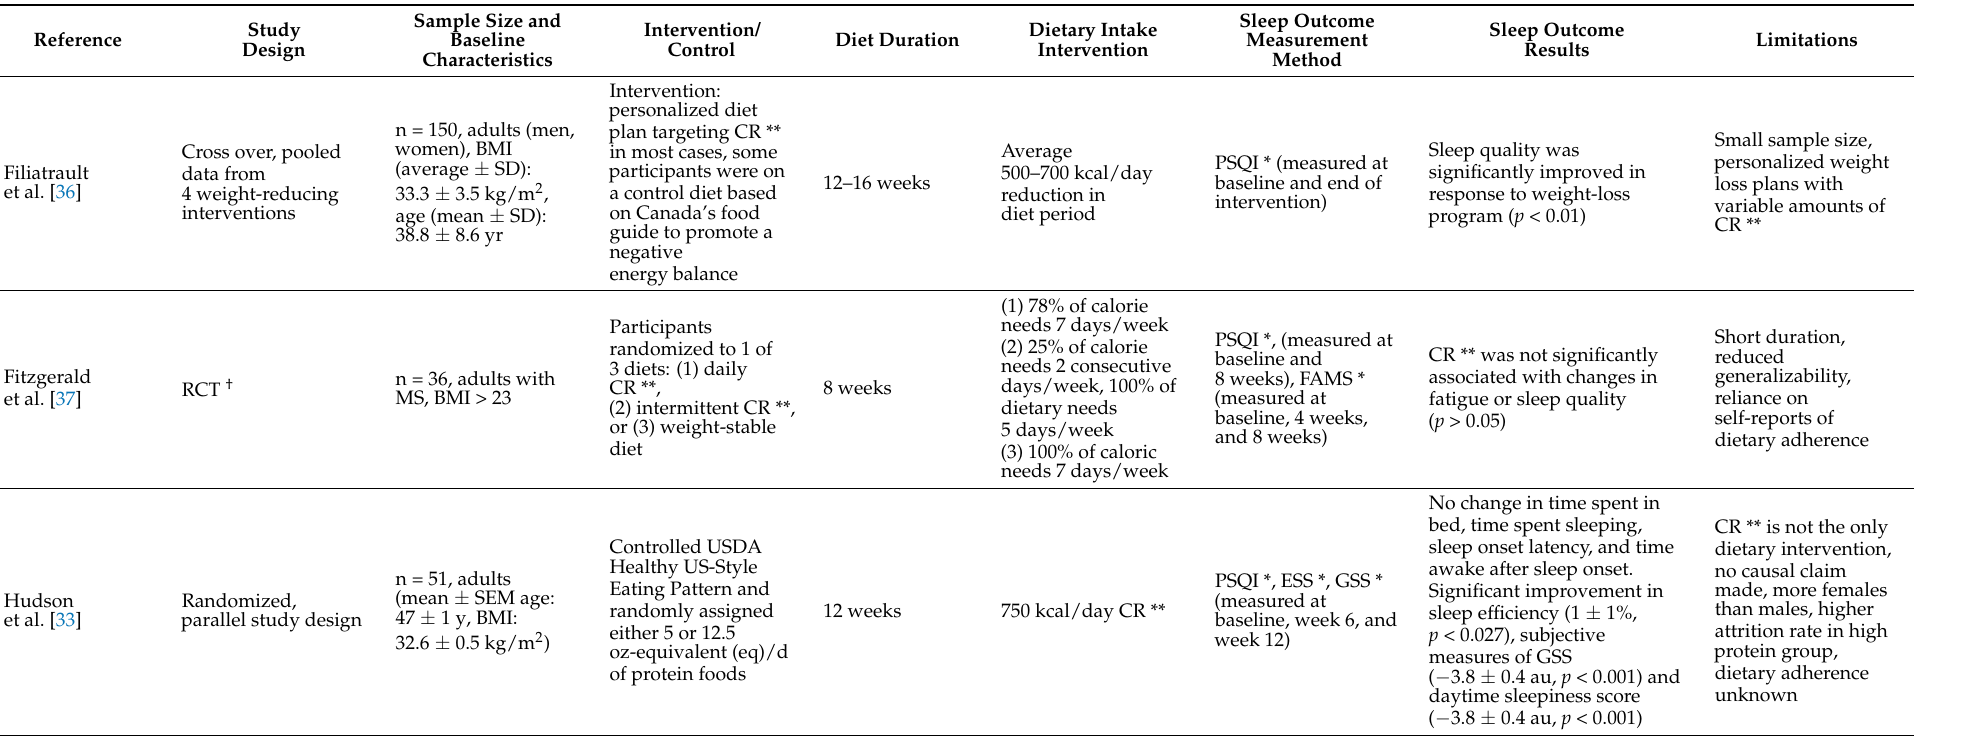
Table 1. Caloric Restriction and Sleep in